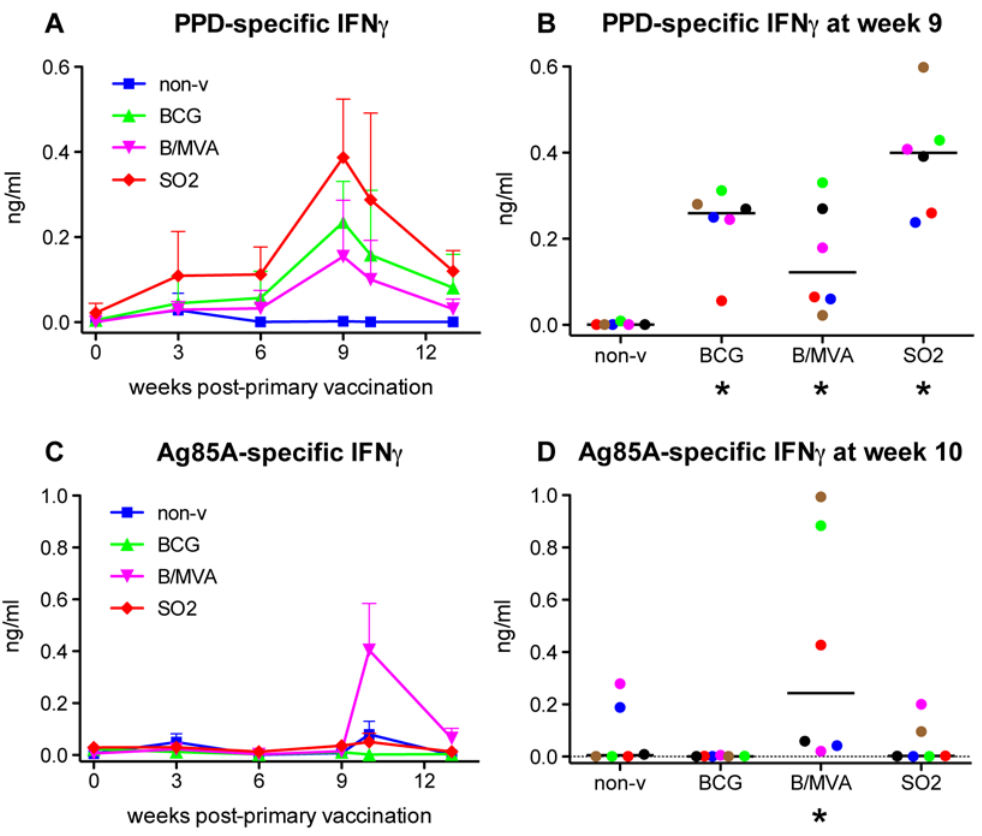
Figure 2. Mycobacterium-specific IFN c secretion post-vaccination. Both the SO2 primary and the MVA.85A booster vaccine are immunogenic in rhesus macaques. Antigen-specific IFN c secretion was measured after 3 days of in vitro stimulation of fresh peripheral blood lymphocytes along the vaccination phase. PPD-specific IFN c secretion is depicted as group mean responses ( + standard error) in time (A), and as individual responses with medians at the peak of the mean group response (B). Similarly, results upon stimulation with recombinant Ag85A are displayed as group means ( + standard error) in time (C), and as individual responses (with medians) at peak (D), respectively. Colouring of group medians (panels A and C) is representing non-vaccinated controls in blue, BCG only in green, BCG/MVA.85A in magenta, and SO2 vaccination in red; group colouring is maintained throughout the paper for comparibility of data. Dot plots representing individual animals (panels B and D) are consistently coloured as follows: animals per treatment group were ranked from highest to lowest total gross pathology score (sum of lung, hilar LN and extra-thoracic scores) and then assigned the colours: blue, green, magenta, red, brown, black, respectively; individual colouring is maintained throughout for comparability. P-values are relative to non-vaccinated control treatment and represented under the x-axis by symbols as follows: &